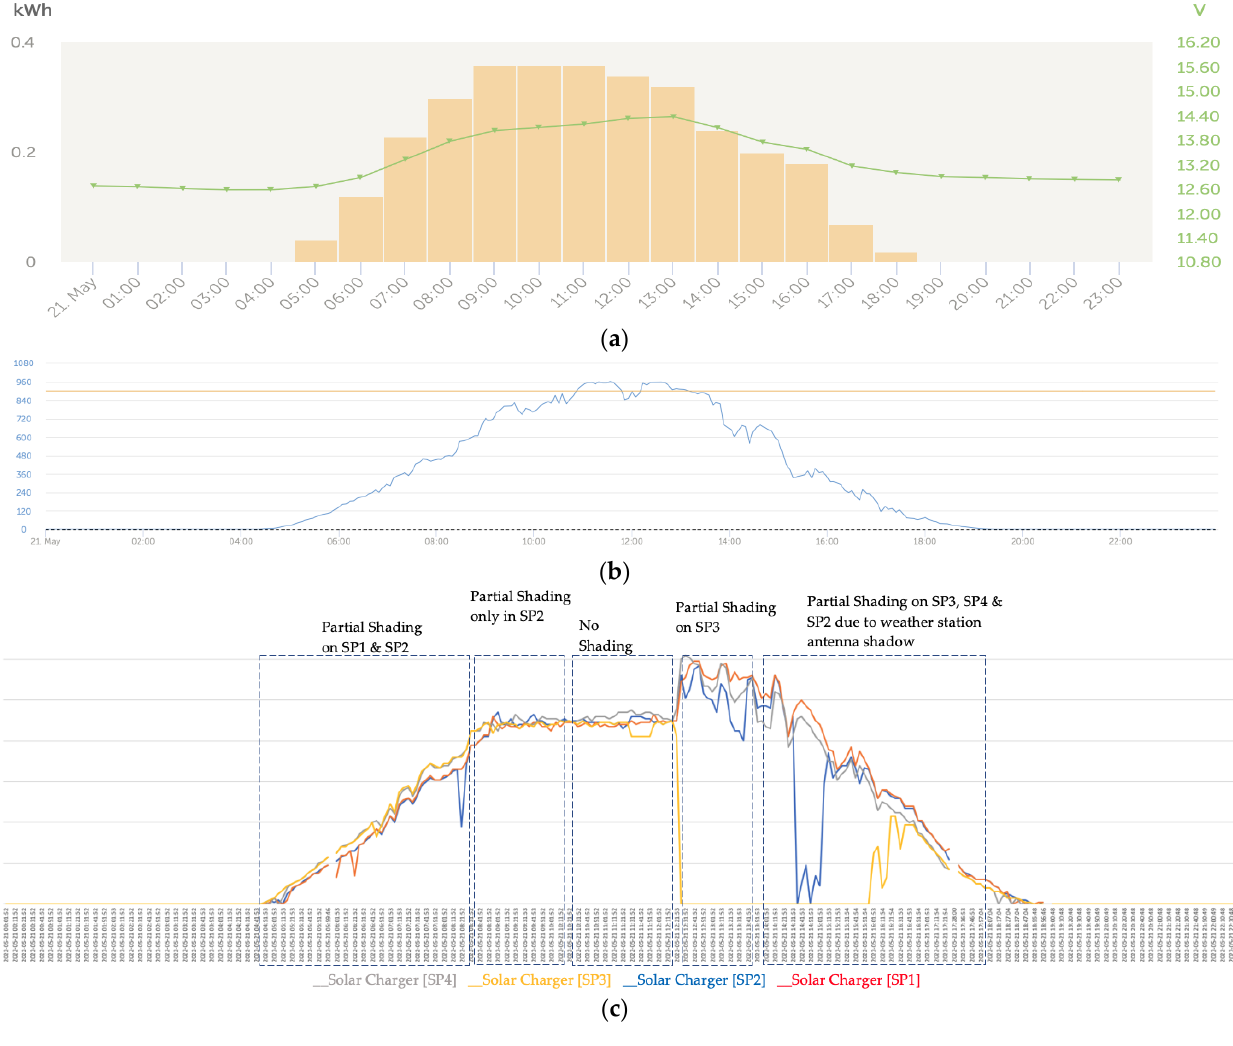
Figure 24. ( a ) Daily charge phases: initial, absorption, and flotation (21 May). ( b ) Irradiance (21 May). ( c ) Deviation trend comparative PV power data series analysis due to partial shading (21 May).